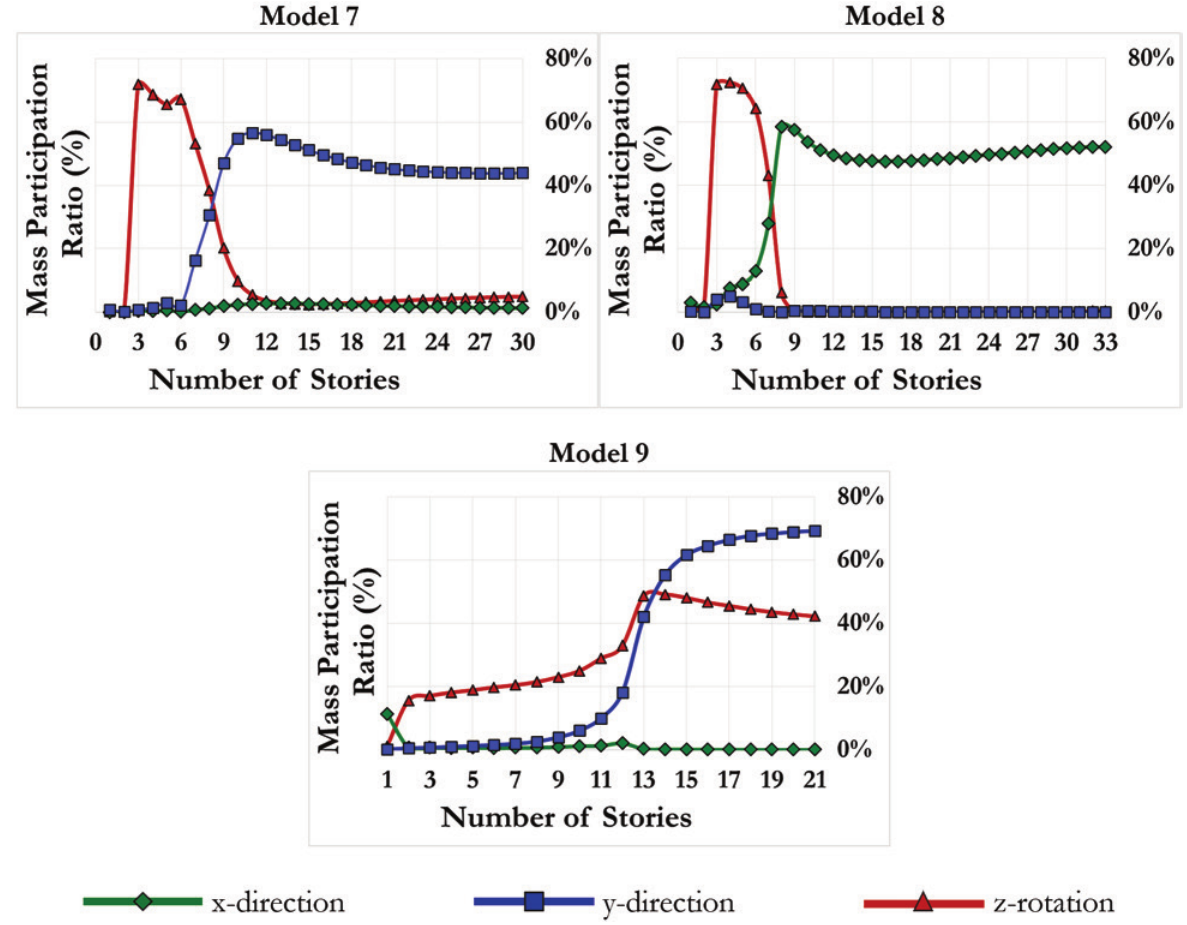
Figure 9 Effective modal mass of the first mode of vibration for models 7, 8 and